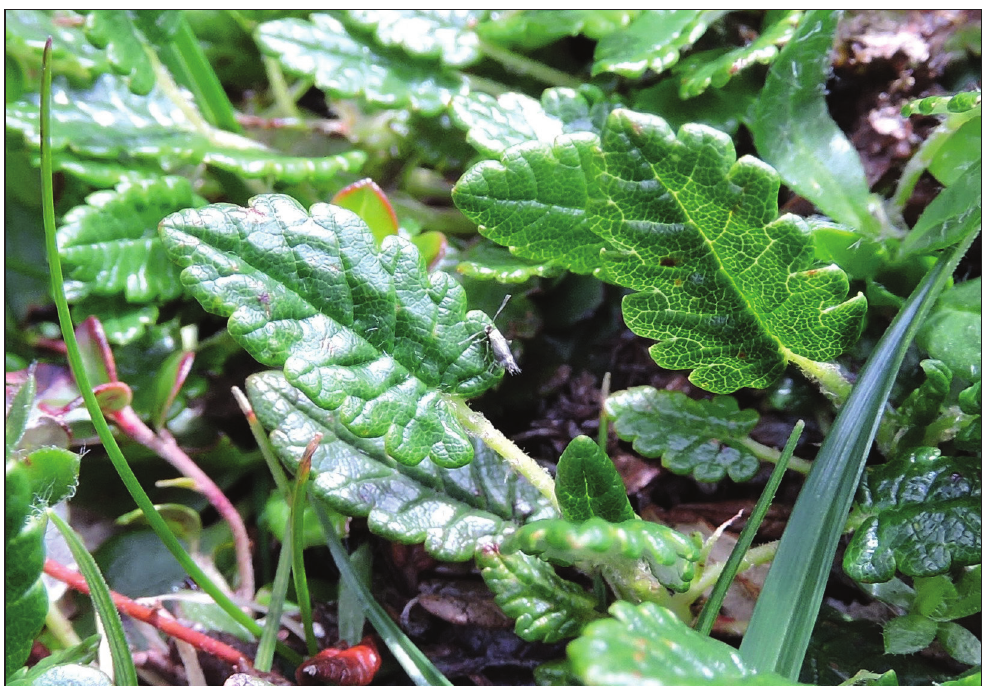
Figure 10. The Belianske Tatra Mts, Zadné Jatky Mt., 30.vii.2016, adult of Stigmella tatrica sitting on Dryas octopetala leaf. Photograph F.